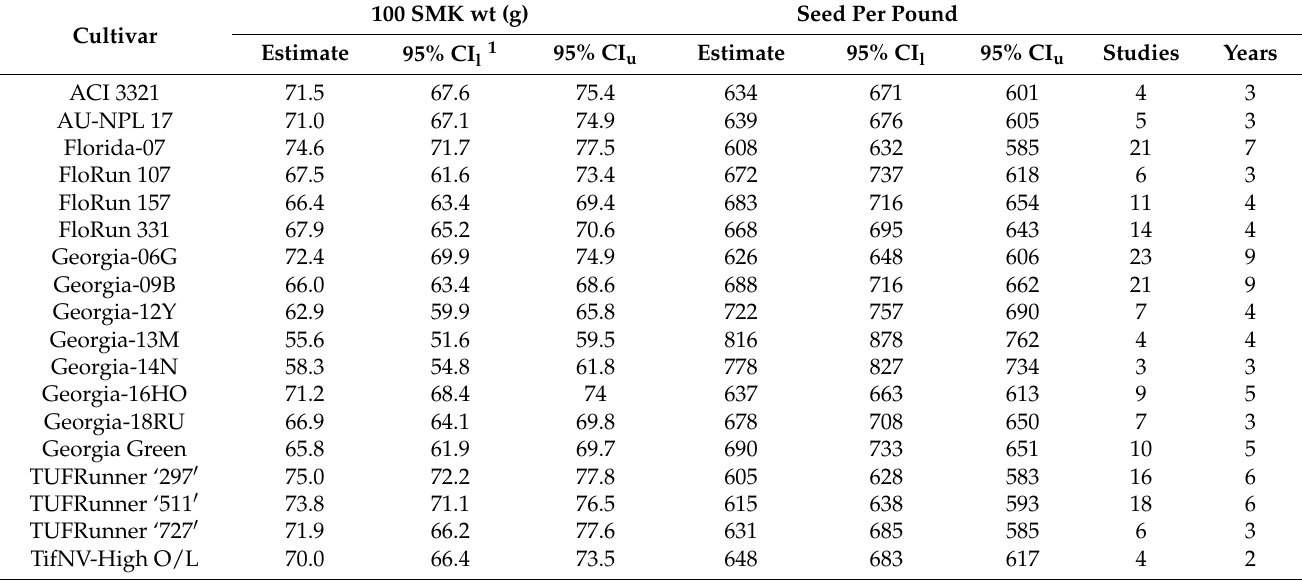
Table 2. Runner market type cultivar 100 sound mature kernel (SMK) weight and corresponding number of seed per pound estimated from field trials conducted in North and South Carolina. Cultivar